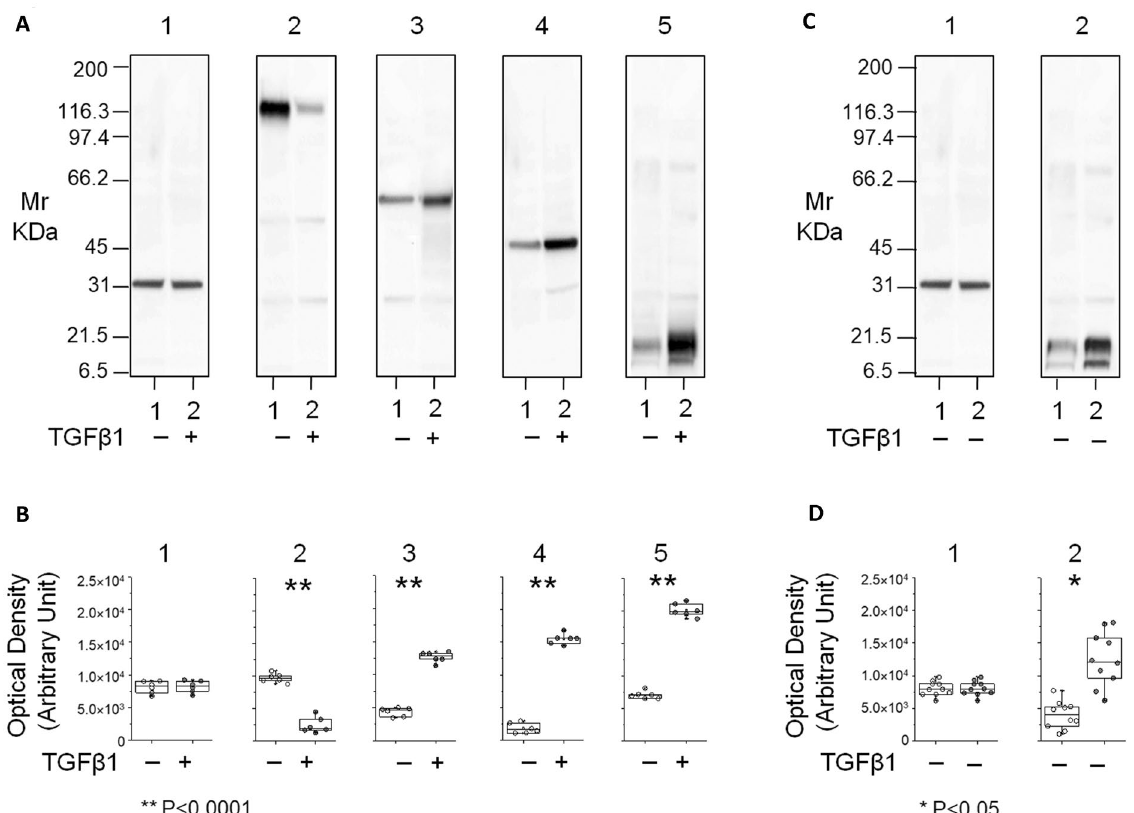
dialysis vintage. ( A ) Representative western blot analysis of full length gel (8–16 T%) for GAPDH (membrane and plot 1), E-cadherin (membrane and plot 2), Vimentin (membrane and plot 3), αSMA (membrane and plot 4) and PTP4A1 (membrane and plot 5) in whole lysate of HPMC treated with TGFβ1 (lane 2 or grey circle) or not (lane 1 or white circle) and ( B ) their densitometry analysis visualized as box plots (six biological replicates). HPMC treated with TGFβ1 showed a reduced expression of the epithelial marker E-cadherin and increased expression of VIME, α-SMA and PTP4A1 ( p < 0.0001); ( C ) Representative western blot analysis of full length gel (8–16 T%) for GAPDH (membrane and plot 1) and PTP4A1 (membrane and plot 2) in exosomes from patients with short (lane 1 or white circle) or long (lane 2 or dark grey circle) dialysis vintage and ( D ) their